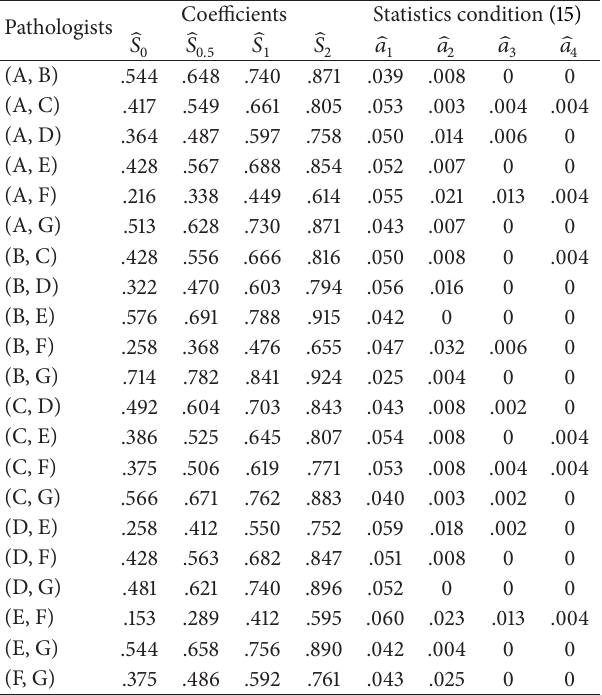
Table 3: Various statistics for the 21 pairwise agreement tables between seven pathologists